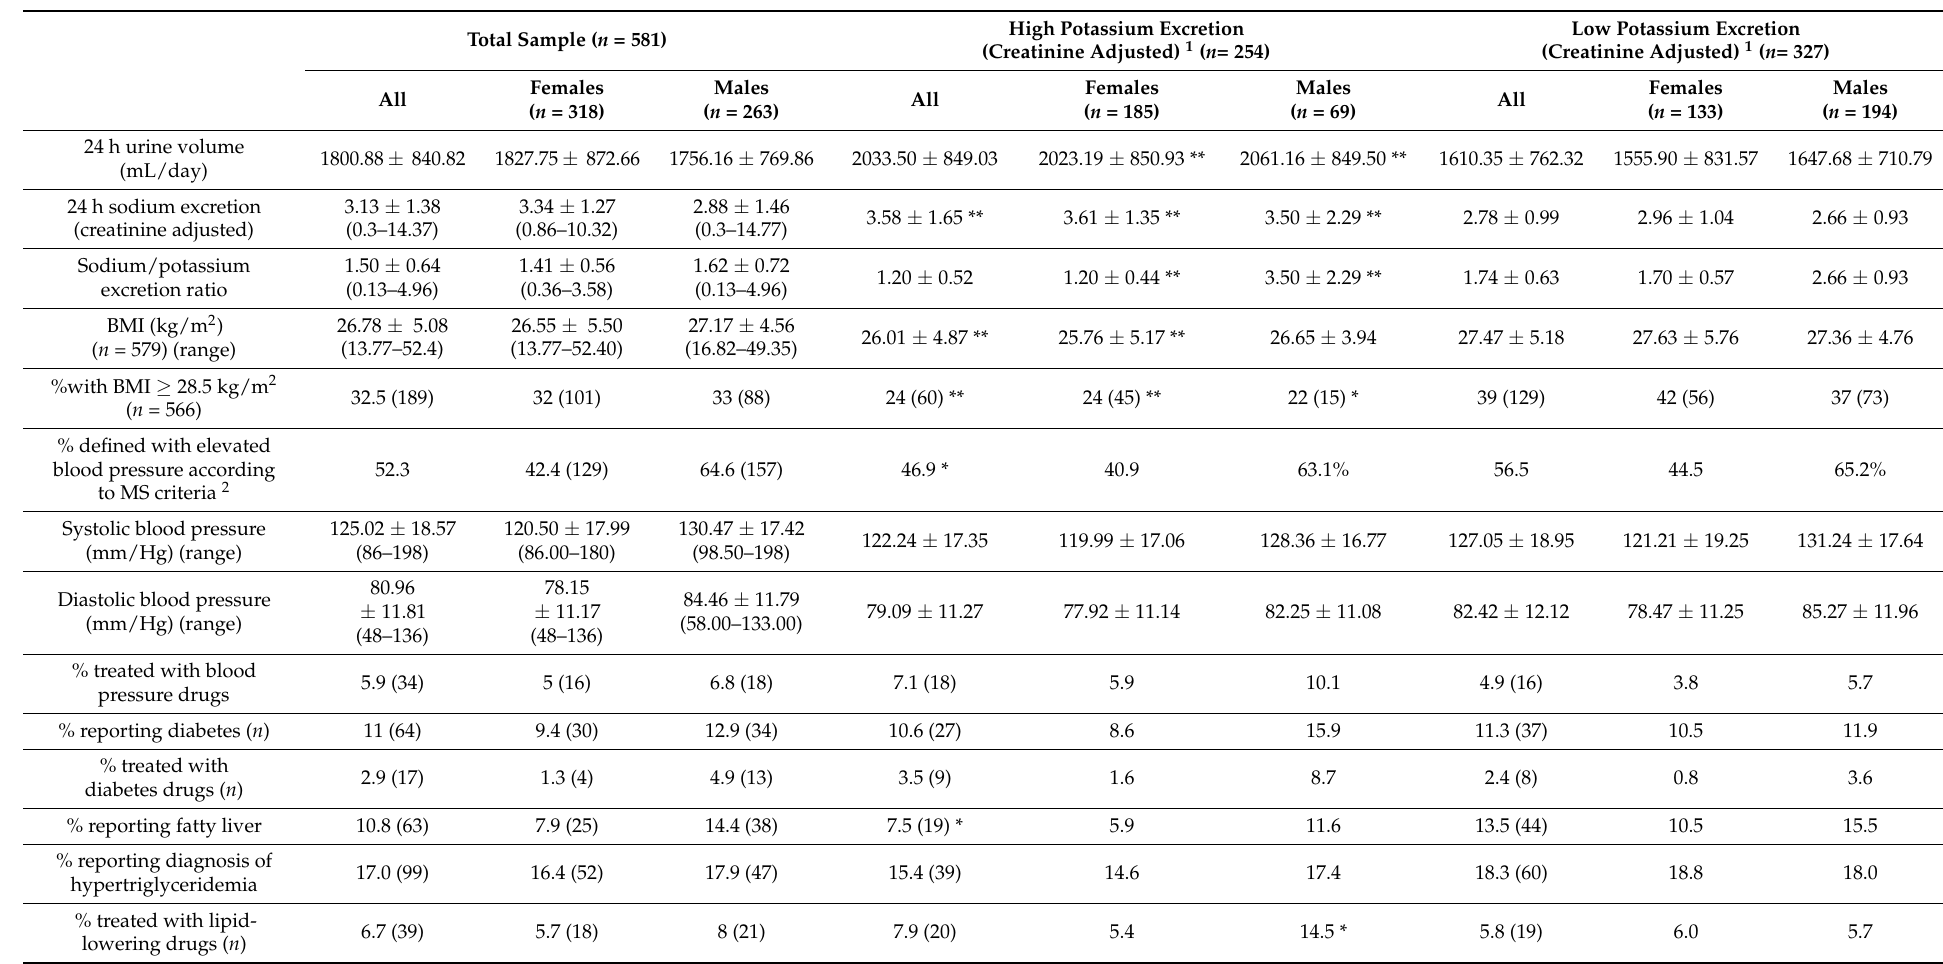
Table 2. Participants’ health/metabolic characteristics with stratification to potassium excretion groups